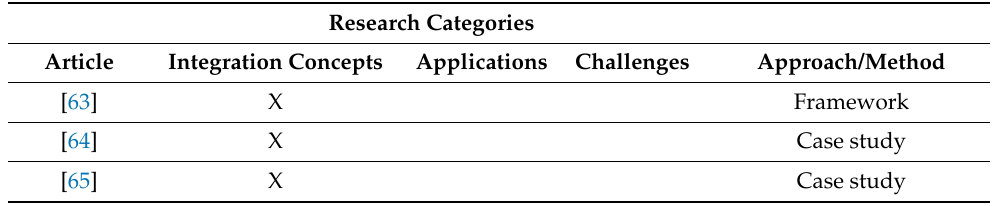
Table 1. Categorisation of the analysed articles. Source: Authors’ elaboration.